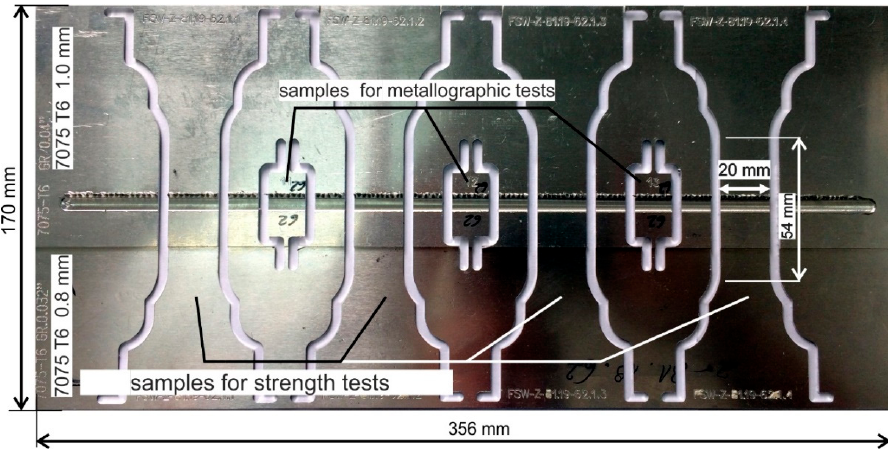
Figure 2. Joint welded during wear tests of FSW tools.